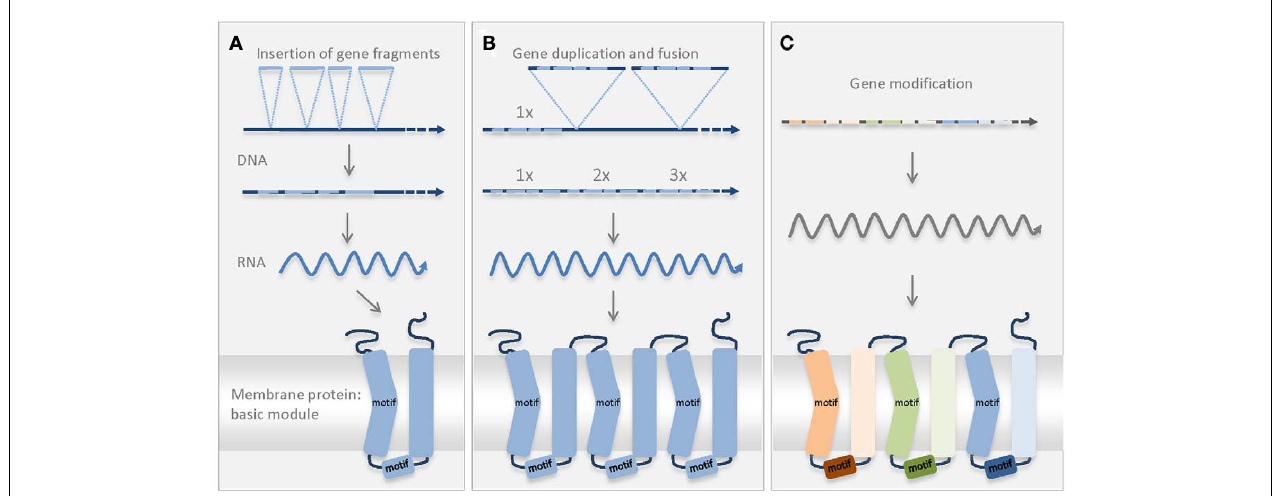
a basic MCF sequence originated by fusion of different smaller gene fragments.The new sequence encodes the postulated basic module of the MCF consisting of two transmembrane helices and of a connecting loop with a helical region. (B) Twofold duplication of the basic sequence and insertion in the genome resulted in the coding sequence of the pre-MCF protein. (C) Gene modification resulted in the establishment of further/different MCF carriers that still exhibit the conserved structure and the MCF